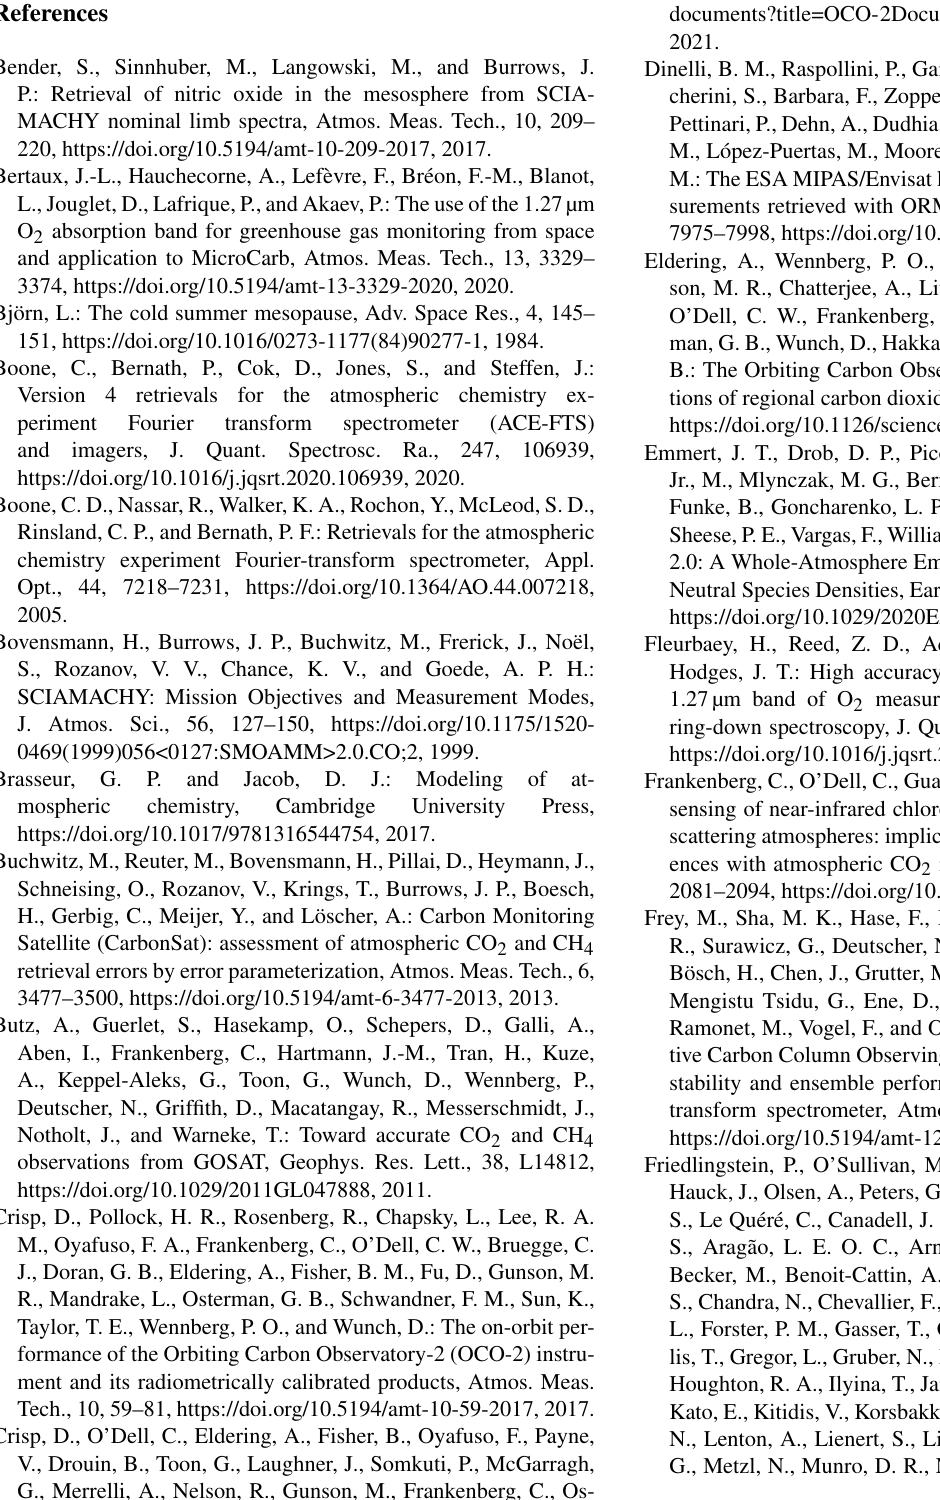
algorithm theoretical basis document, OCO-2 Level 2